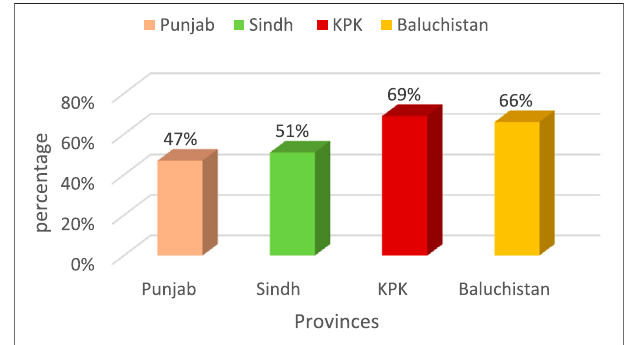
FIGURE 1 | Comparison of energy poverty at provincial level (Sher et al.,